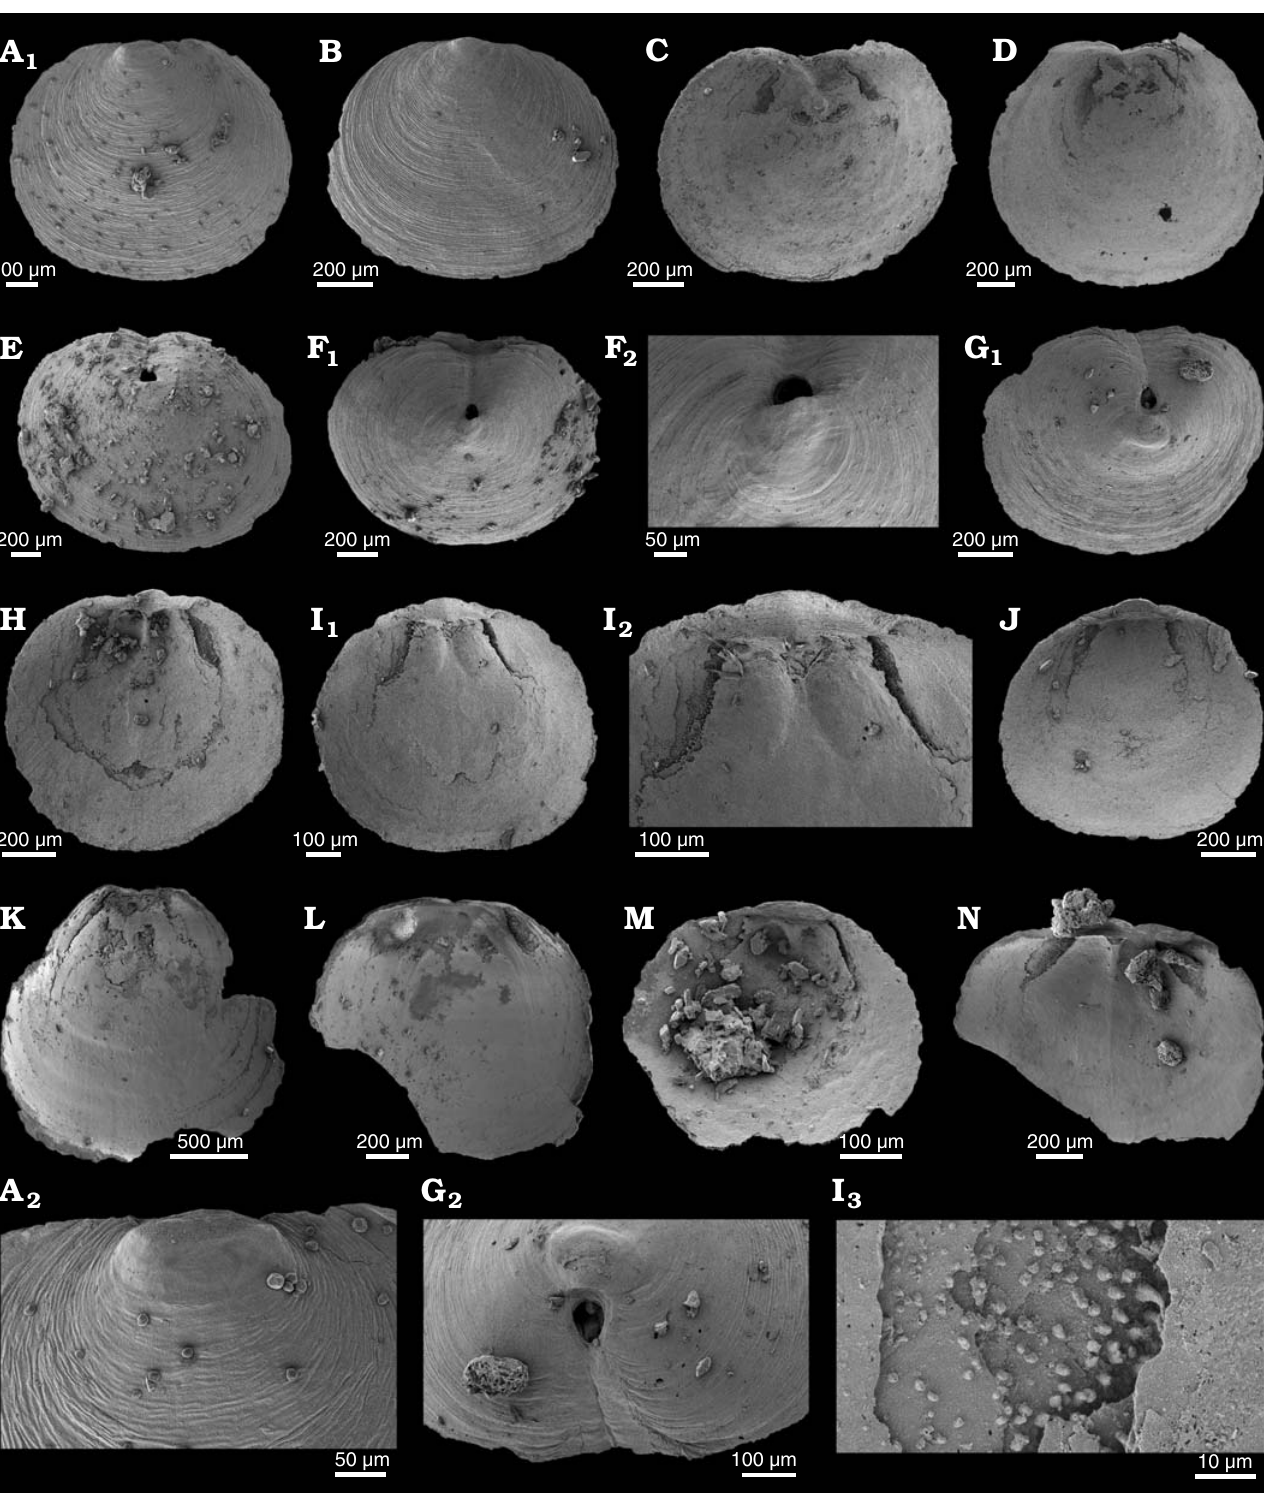
Fig. 10. The lingulid brachiopod Eohadrotreta sp. cf. E. zhenbaensis Li and Holmer, 2004 from the lower Cambrian White Point Conglomerate, Kangaroo Island, South Australia. Dorsal (A, B, H–J, M, N) and ventral (C–G, K, L) valves. A . SAM P57276 in external view (A 1 ); A 2 , detail of the larval shell. B . SAM P57277 in external view. C . SAM P57278 in internal view. D . SAM P57279 in internal view. E . SAM P57280 in external view. F . SAM P57281 in external view, tilted to show intertrough (F 1 ); F 2 , detail of the foramen. G . SAM P57282 in external view, tilted to show intertrough (G 1 ); detail of the foramen (G 2 ) showing the intertrough. H . SAM P57283 in internal view. I . SAM P57284 in internal view; I 2 , close up of interarea; I 3 , detail of shell microstructre. J . SAM P57285 in internal view. K . SAM P57286 in internal view. L . SAM P57287 in internal view. M . SAM P57288 in internal view. N . SAM P57289 in internal